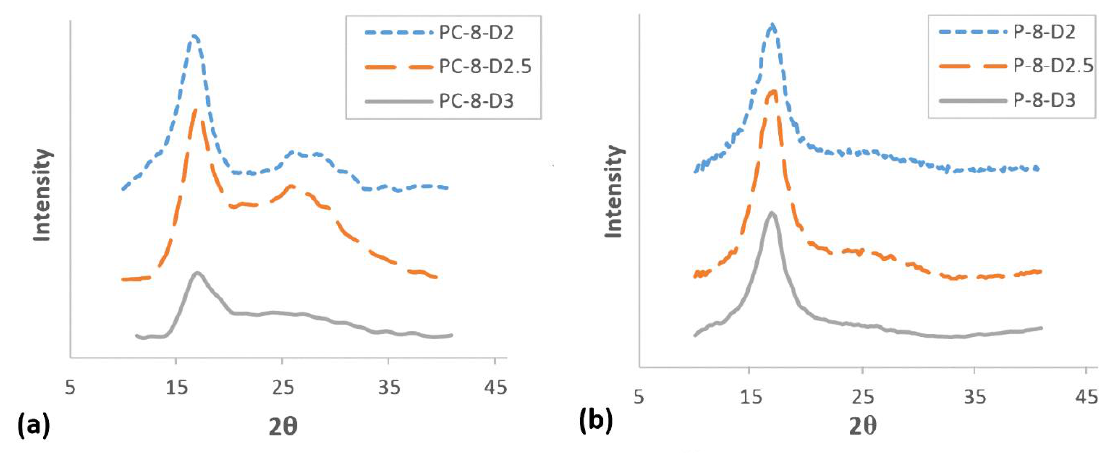
Figure 9. XRD patterns of fibers spun at different jet stretch ratios. ( a ) PAN/CNT, ( b ) PAN.